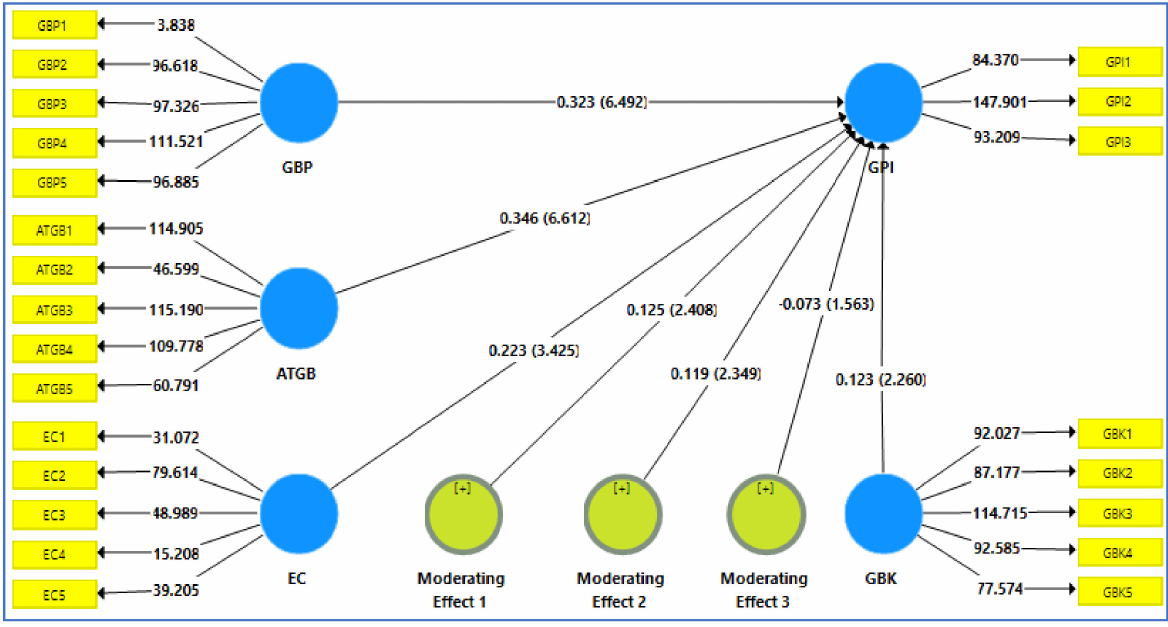
Figure 2. Moderating effect